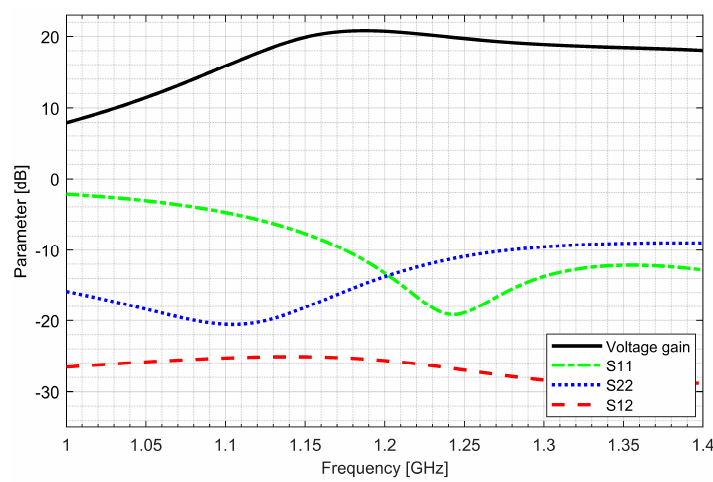
Figure 5. S-matrix and voltage gain characteristics of the L5/E5 low-noise amplifier.